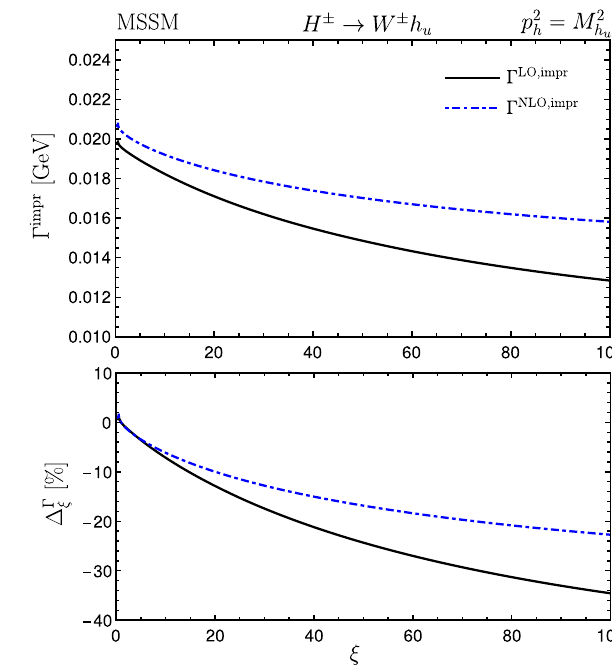
Eq.(37).TheupperpanelsshowthegaugedependenceoftheLO(black, solid) and NLO (blue, dot-dashed) widths. In the lower panels we dis- play the relative gauge dependence of the LO and NLO